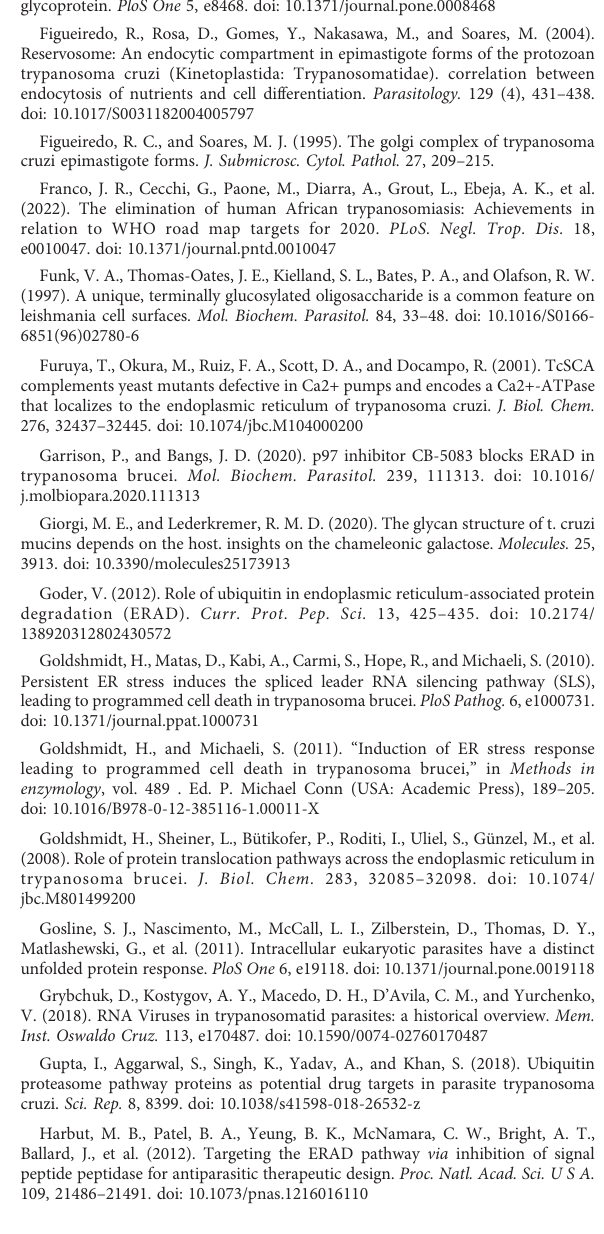
Figueiredo, R. C., and Soares, M. J. (1995). The golgi complex of trypanosoma cruzi epimastigote forms. J. Submicrosc. Cytol. Pathol. 27, 209 – 215.